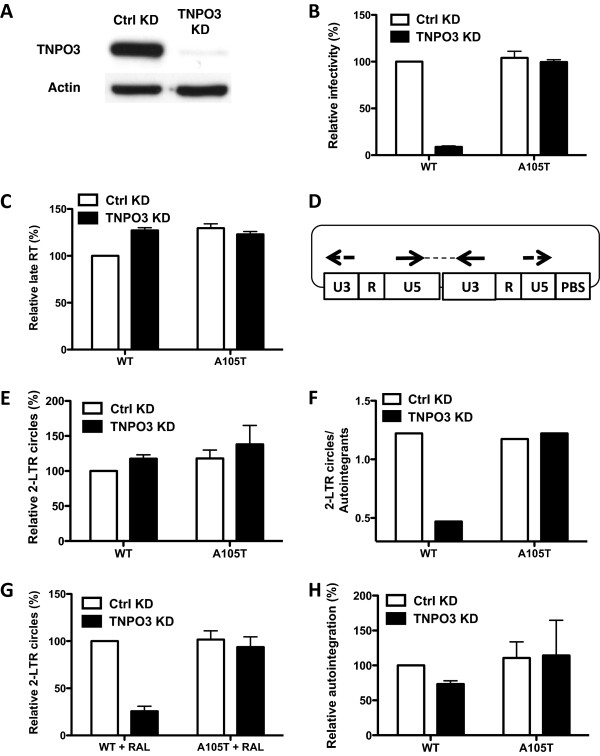
TNPO3 depletion decreases the level of HIV-1 2-LTR circles and has no effect on autointegration. (A) TNPO3 protein in TZM-bl cells transduced with lentiviral vectors expressing shRNAs targeting TNPO3 or control (Ctrl). Cell lysate was probed in western blots with anti-TNPO3 antibody (upper panel) or anti-β-actin antibody (lower panel). (B) TZM-bl control (Ctrl) cells and TNPO3 KD cells were challenged with HIV-1-GFP reporter vectors bearing either WT or A105T CA mutation. 72 hrs after transduction, the percent GFP+ cells was determined by flow cytometry as an indication of infectivity. (C) Quantification of late RT products 24 hrs post-infection with WT or A105T CA mutant viruses, on control (Ctrl) or TNPO3 KD cells. (D) Schematic representation of qPCR for 2-LTR circles using primers flanking the circle junction. Arrows represent primers. Dashed line represents the PCR product. (E) Quantification of 2-LTR circles (as indicated in B) 24 hrs post-infection with WT or A105T CA mutant viruses, on control (Ctrl) or TNPO3 KD cells. The PCR products were detected using Sybr green. (F) The PCR products from (E) were cloned and sequenced. The ratio between 2-LTR circles and autointegration events is plotted. (G) The analysis from (E) was repeated in the presence of raltegravir (RAL) 10 μM. (H) Level of autointegration events by qPCR when WT or A105T CA mutant viruses infect control (Ctrl) or TNPO3 KD cells.